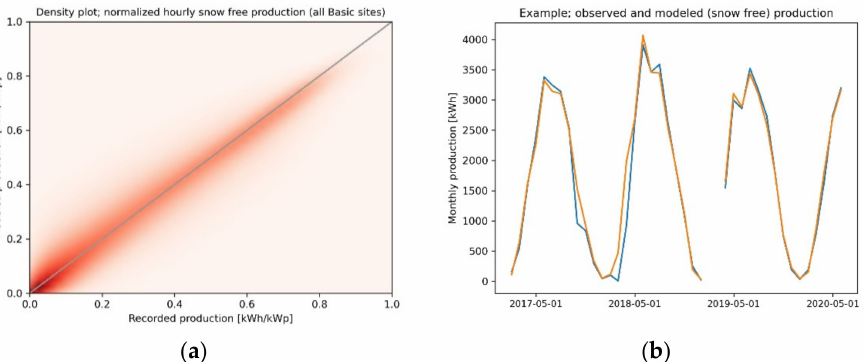
Figure 5. Illustration of the performance of the inferred snow-free model: ( a ) density plot for measured and modeled hourly snow-free production normalized with the installed effect and ( b ) example of monthly modeled snow-free and actual observed production at one of the basic